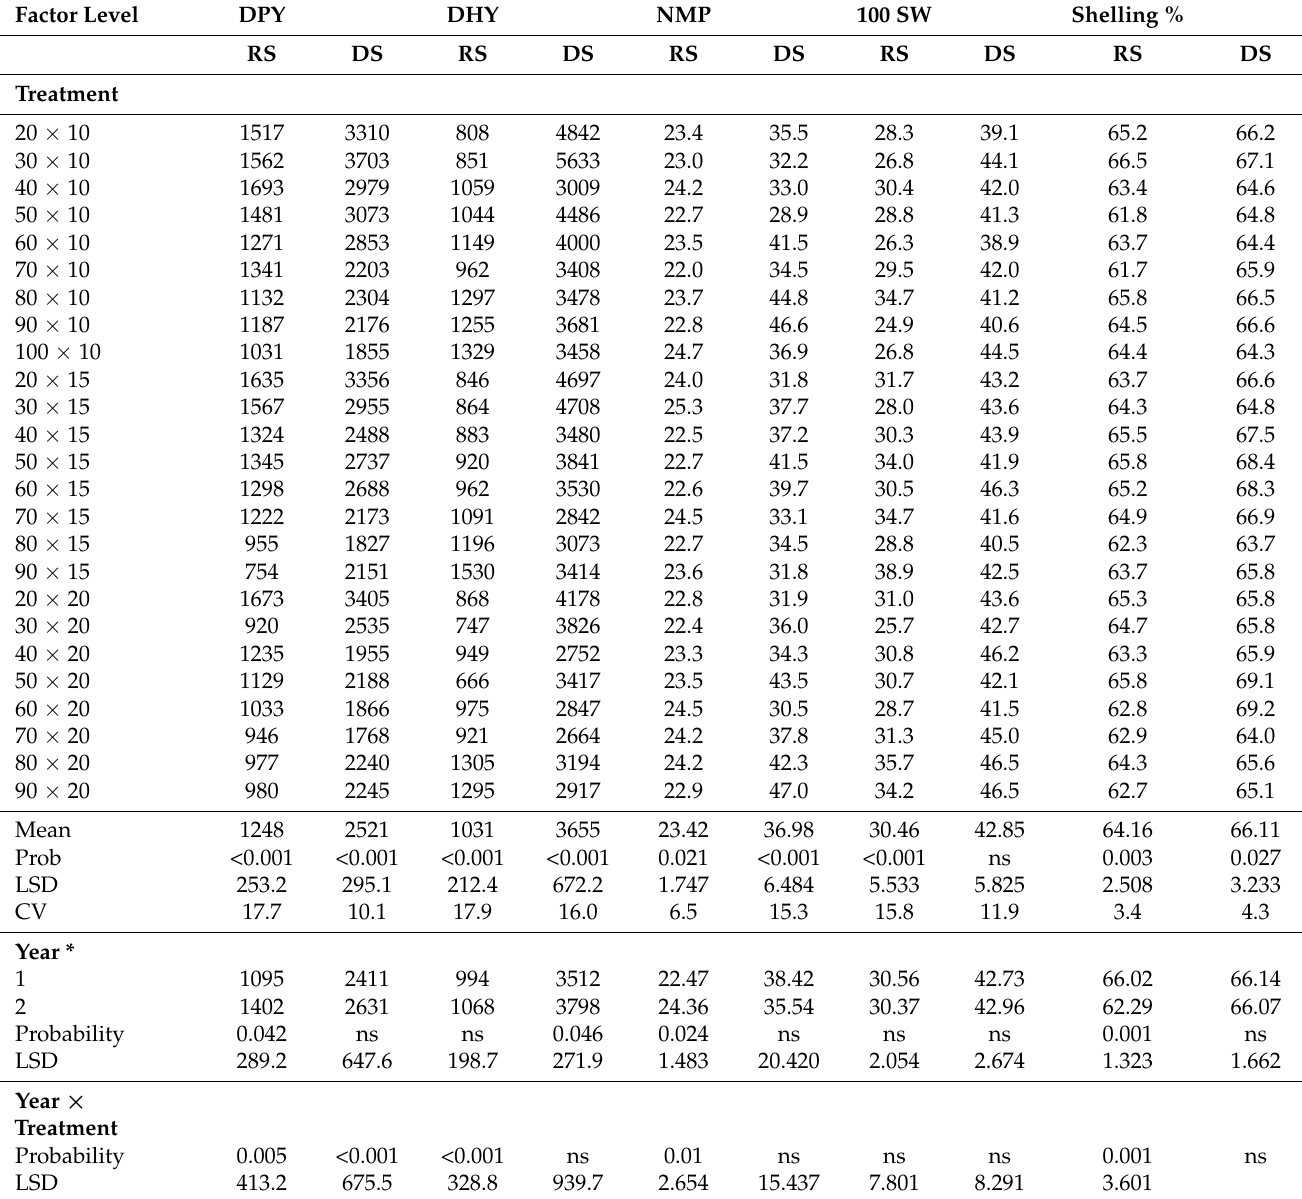
Table 6. Mean performance of spacing treatments for DPY, DHY, NMP, 100 SW, and shelling % across years during rainy season in 2016 and 2018, and dry season in 2020 and